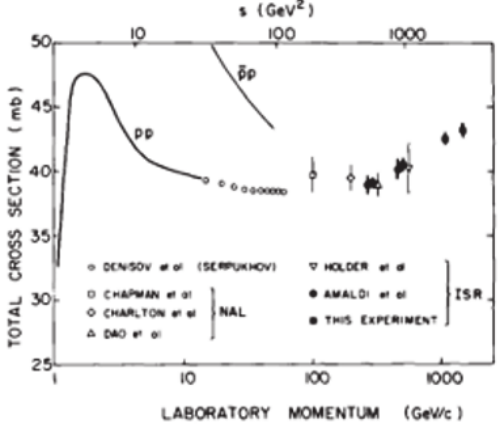
Fig.4 . Rise in the total p-p cross-section as reported in